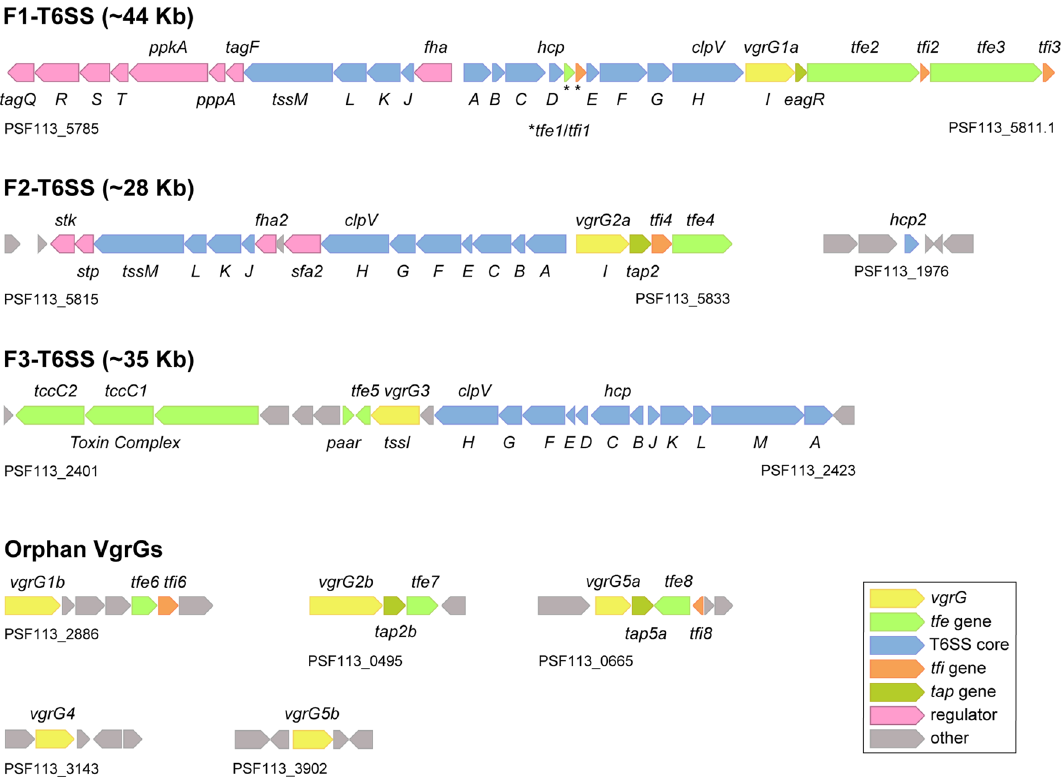
Figure 2. Genetic organization of T6SS clusters in P. fluorescens F113. Schematic representation of the F1-, F2-, F3-T6SS clusters and the vgrG and hcp orphan clusters. The colour code of the genes indicates their predicted role according to the colour legend shown. The core genes tssA - M are indicated by a letter. Genes are represented as blocked arrows showing the direction of their transcription. The genes are to scale.